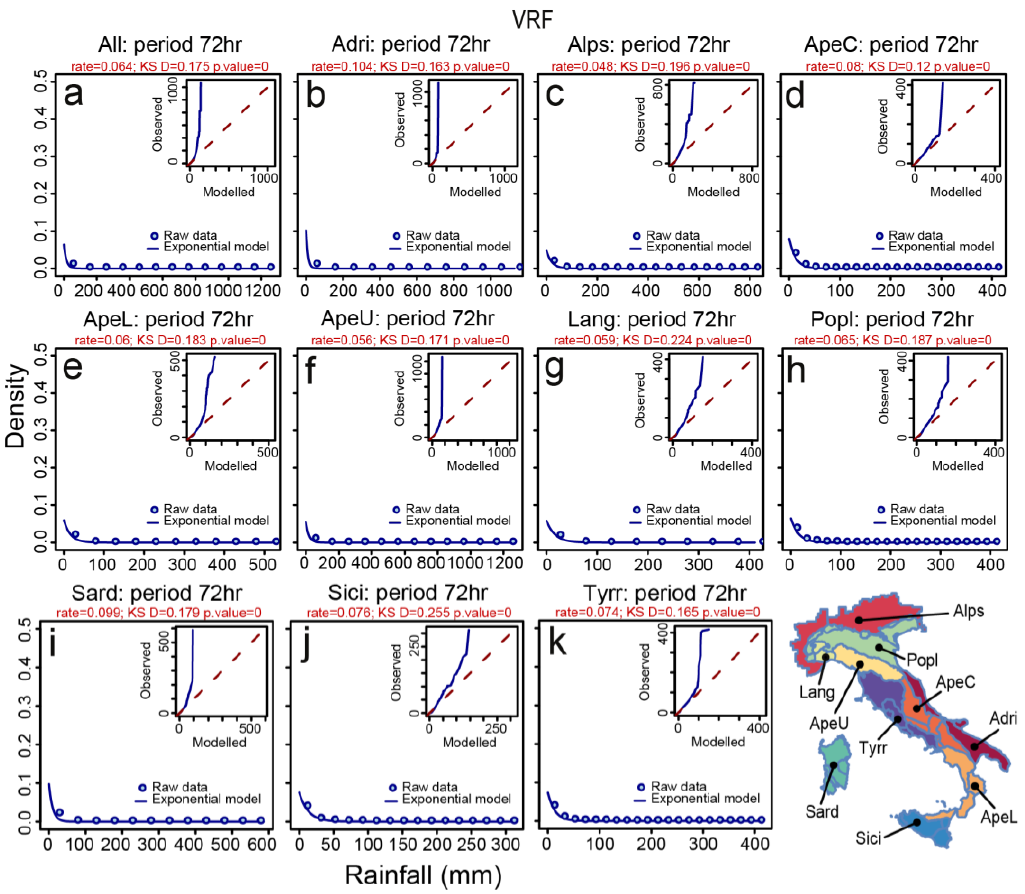
Figure 11. Exponential distribution estimated for 72-h cumulative rainfall using the MLE method for VRF data. The different plots show results for different Italian morphological subdivisions: ( a ) entire Italian territory; ( b ) Adri; ( c ) Alps; ( d ) ApeC; ( e ) ApeL; ( f ) ApeU; ( g ) Lang; ( h ) Popl; ( i ) Sard; ( j ) Sici; ( k ) Tyrr. The insets show QQ-plot measuring the fitting performance of the exponential model. KS D and p -value are two-sided bootstrapped Kolmogorov-Smirnov test statistics (see Table 6).